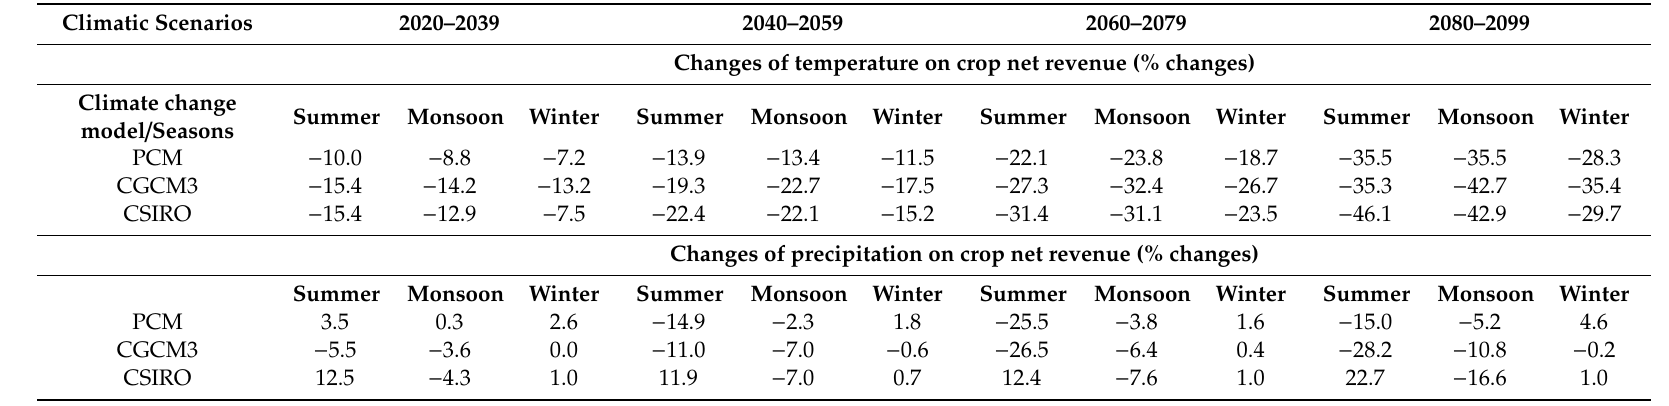
Table 5. Climate predictions of Special Report on Emissions Scenarios (SRES) from 2020–2100 years. Climatic